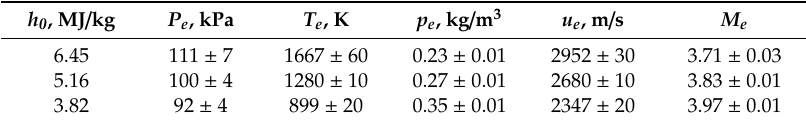
Table 2. Combustor inlet conditions.